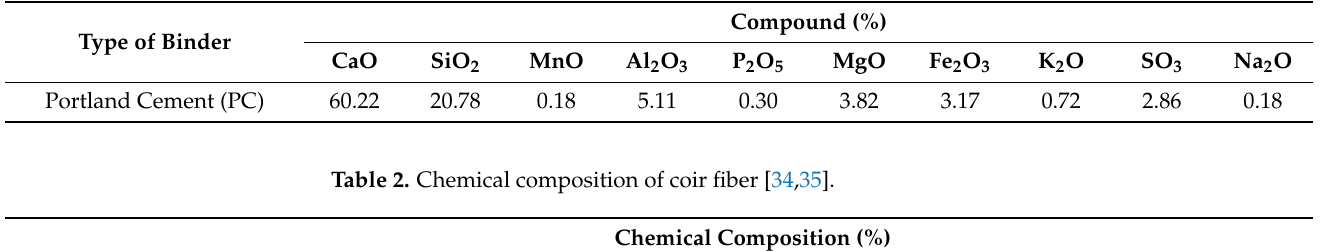
Table 1. Chemical composition of PC.